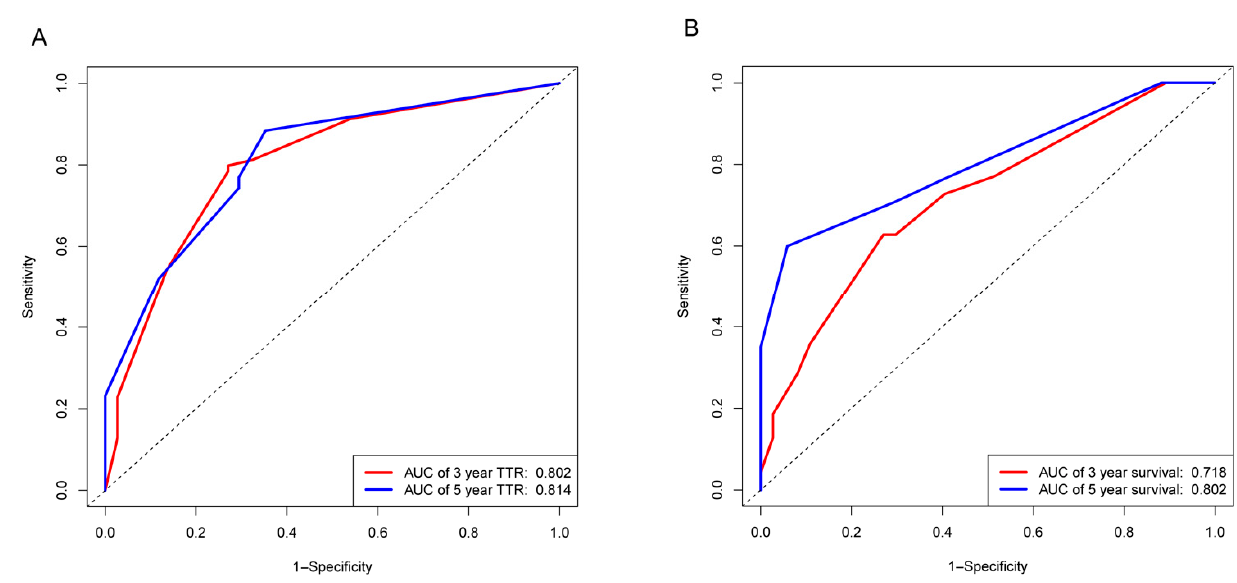
Figure 3. Receiver operating characteristic (ROC) curves of nomograms. ( A ) ROC curves of 3- (red line) and 5-year (blue line) TTR based on our nomogram. ( B ) ROC curves of 3- (red line) and 5-year (blue line) OS based on our nomogram. The X -axis represents 1-specificity. The Y -axis represents sensitivity.